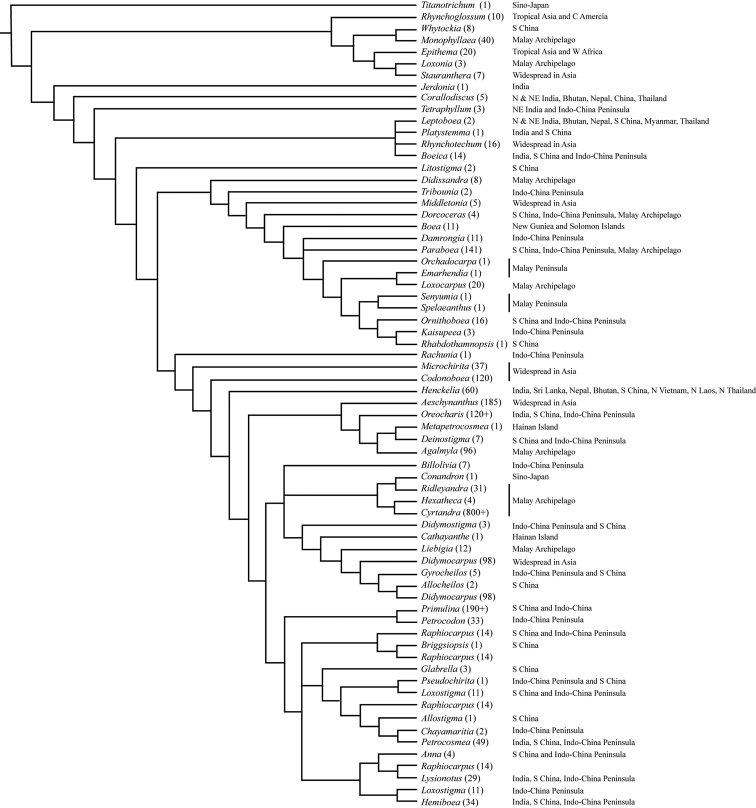
Genera phylogeny with geographical distribution pattern of the Asian Gesneriaceae. The number in the brackets is the species diversity of the genus. Phylogeny tree was redrawn based on Möller and Clark (2013), Middleton et al. (2015), Puglisi et al. (2016), Möller et al. (2016a), Middleton et al. (2018).